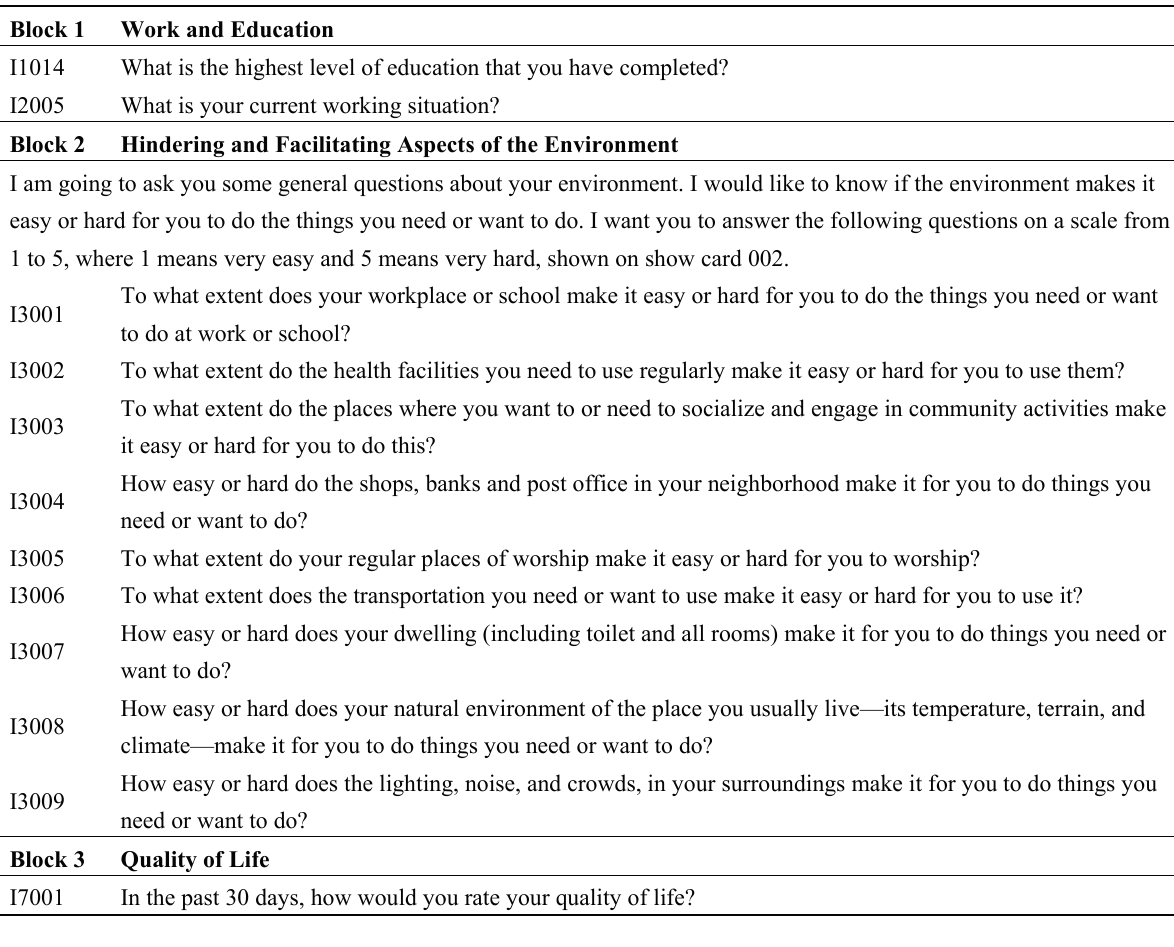
Table 2. Items of the Model Disability Survey, Alpha version, used to exemplarily compare samples of persons classified as “disabled” and “non-disabled”, as well as persons classified as having mild, moderate or severe levels of